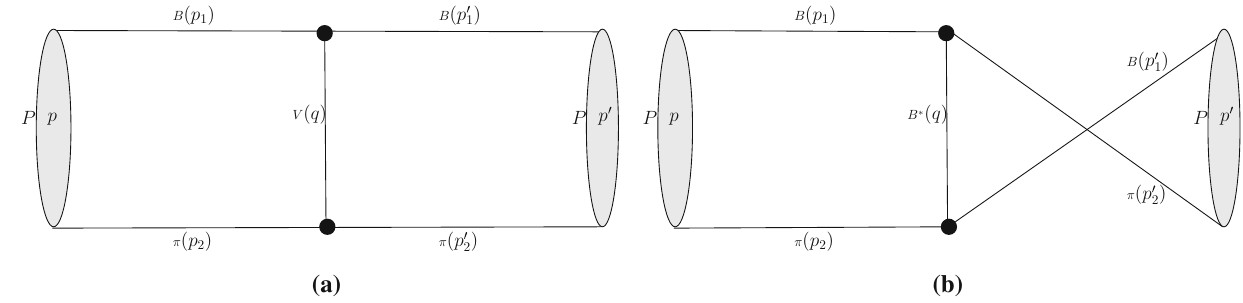
Fig. 1 The bound states of B π formed by exchanging light vector mesons ( a ) and B ∗ ( b )